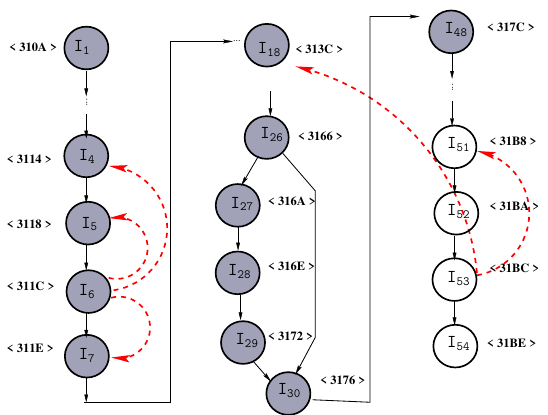
Figure 6: Control Flow Graph (CFG) with addresses ( h · i ) for the intermediate representation of the pseudo-code given in Figure 2. The addresses correspond to an implementation on TI’s MSP-430, while the shaded nodes are vulnerable. A fault in the program counter can skip instructions or repeat the execution of instructions as shown by the dashed lines.